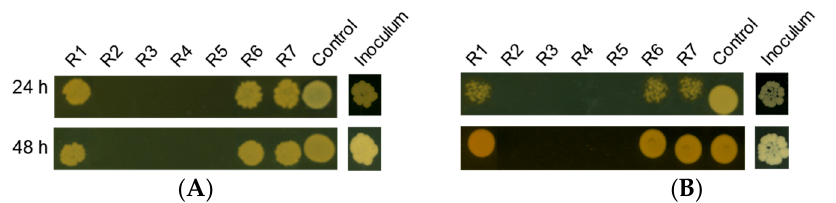
Figure 6. Growth of Candida spp. with different sub-fractions of E35-DF. Yeast cells were incubated with the sub-fractions for 24 h and 48 h and a volume of 5 µL was spotted onto YPD agar plates. Images were digitalized after 24 h of incubation at 37 °C for C. glabrata ( A ) or 30 °C for C. albicans ( B ). The concentrations tested are listed in Table 4. Inoculum: growth prior to sub-fraction addition; untreated control cells. Table 5. MIC values (µg/mL) of fraction E35-DF and of the resulting sub-fractions R2 to R5 for C. albicans and C. glabrata.